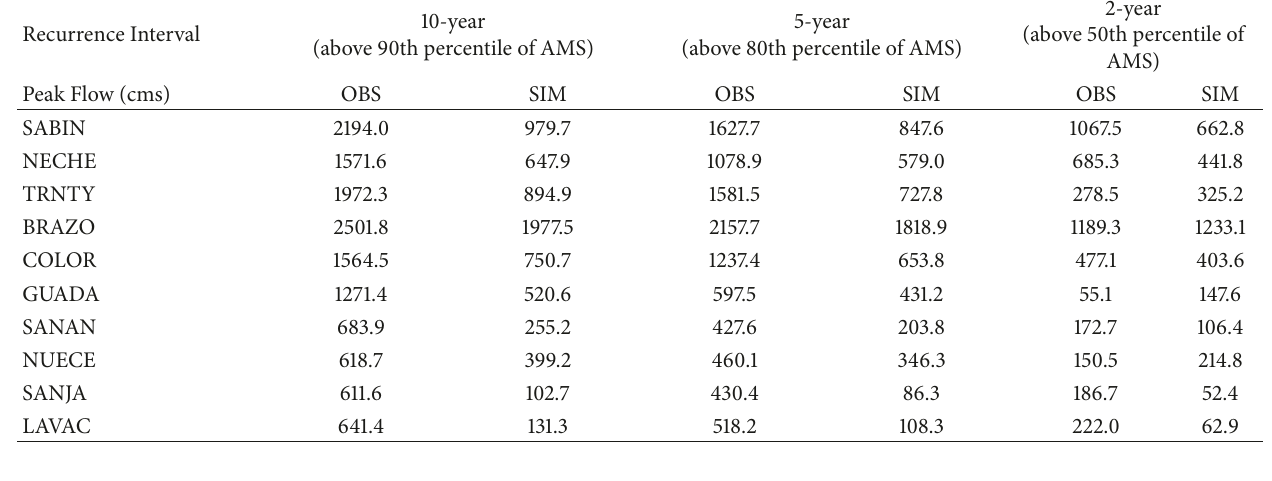
Table 4: Peak flows under different recurrence intervals.